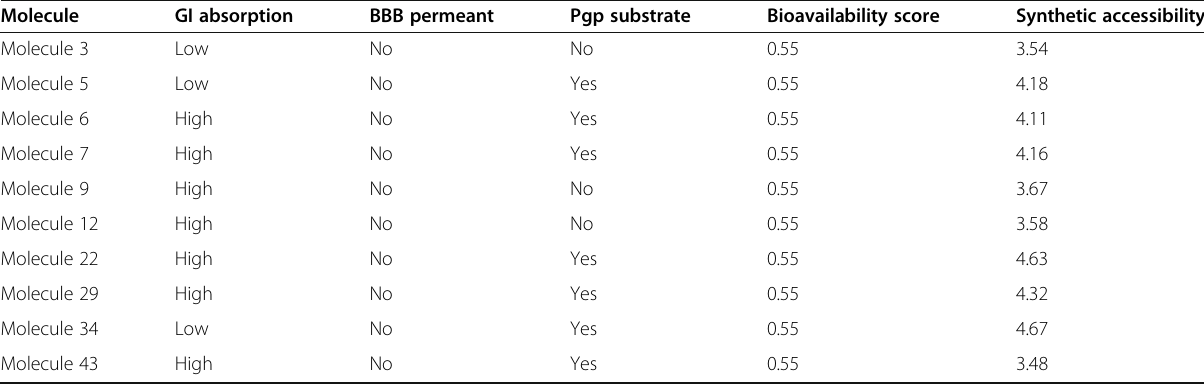
Table 3 ADME properties of ten top compounds Molecule GI